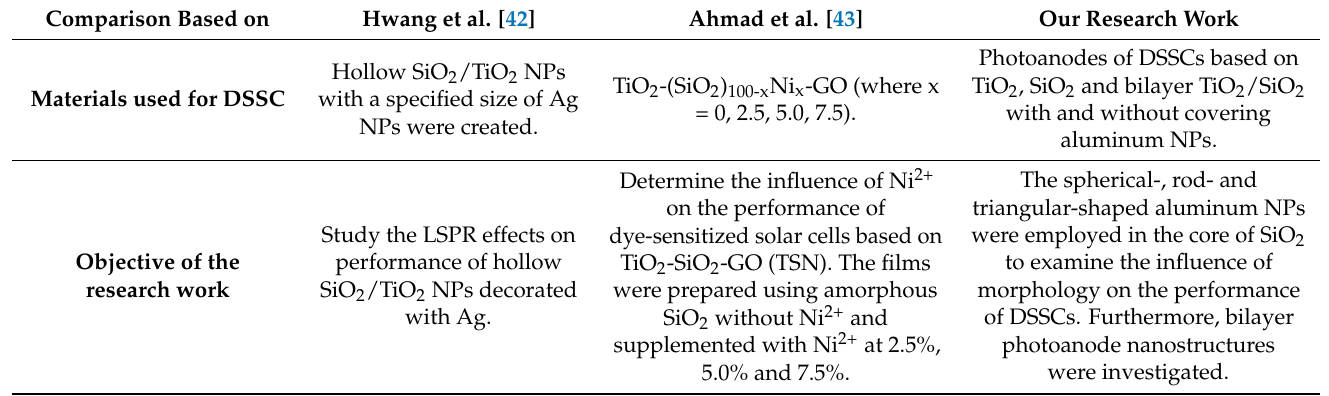
Table 4. Comparison with other relevant research